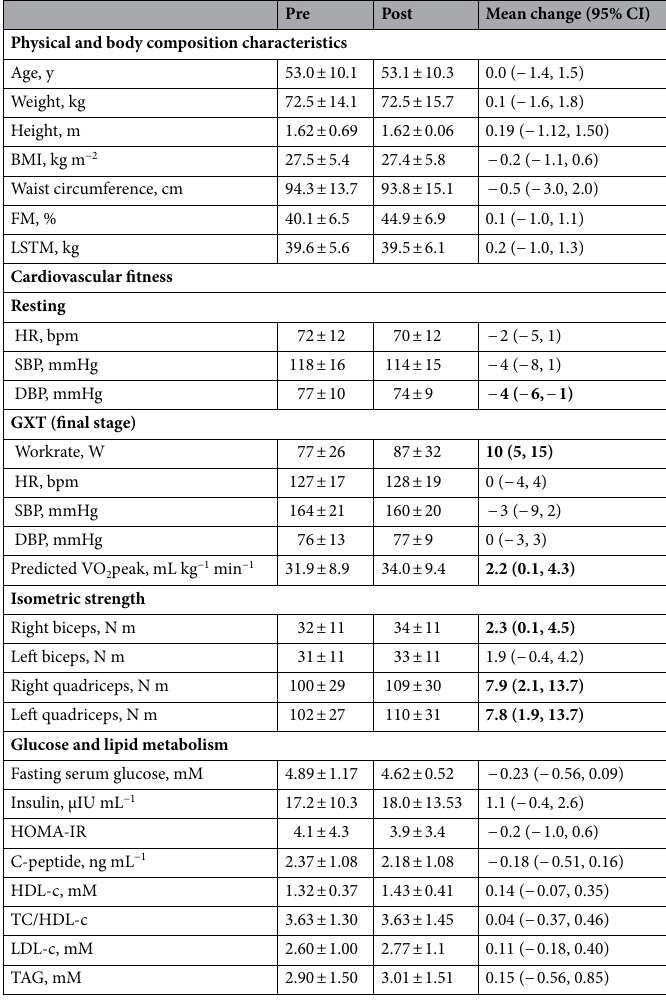
Table 3. Pre- and post-intervention measures. Data are mean ± SD unless otherwise indicated. Pre- and post-intervention measurements were compared using 2-tailed paired t-tests on pooled multiple imputation data. Bolded values indicate statistically significant changes. ALMI appendicular lean mass index, BMI body mass index, DBP diastolic blood pressure, FM fat mass, FFM fat-free mass, HDL-c high-density lipoprotein cholesterol, HOMA-IR homeostatic model assessment of insulin resistance, HR heart rate, LDL-c low-density lipoprotein cholesterol, SBP systolic blood pressure, TAG triglycerides; VO 2 oxygen